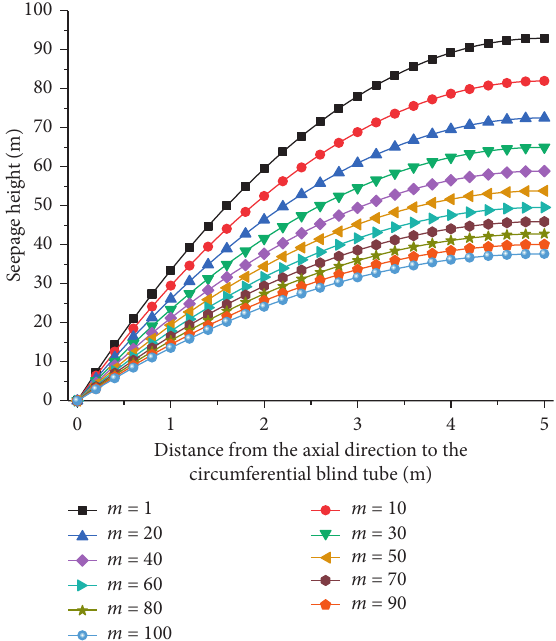
Figure 7: Relationship between the permeability coefficient of the grouting circle and the head